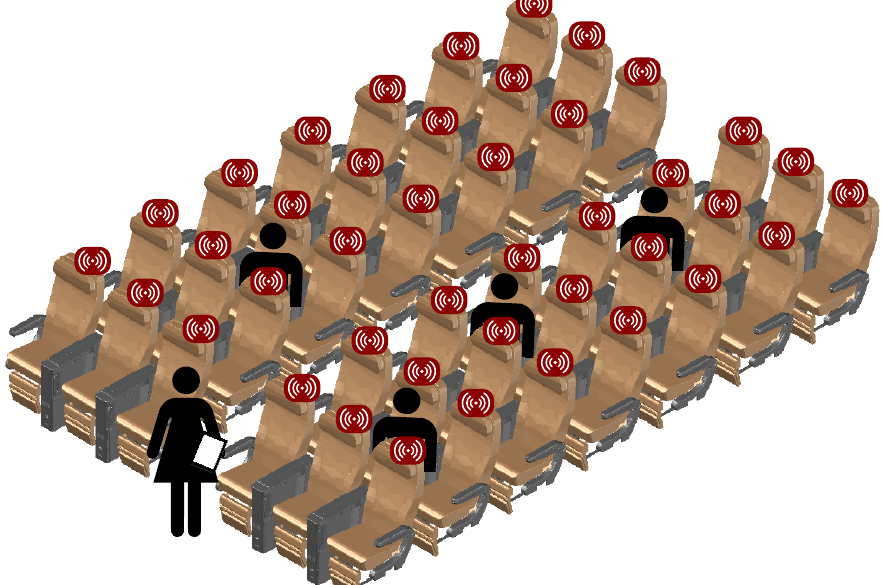
Figure 16. Future connected aircraft cabin system for communication, localization and